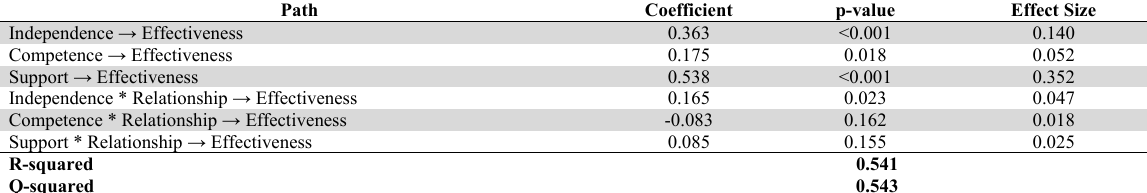
Hypothesis Testing